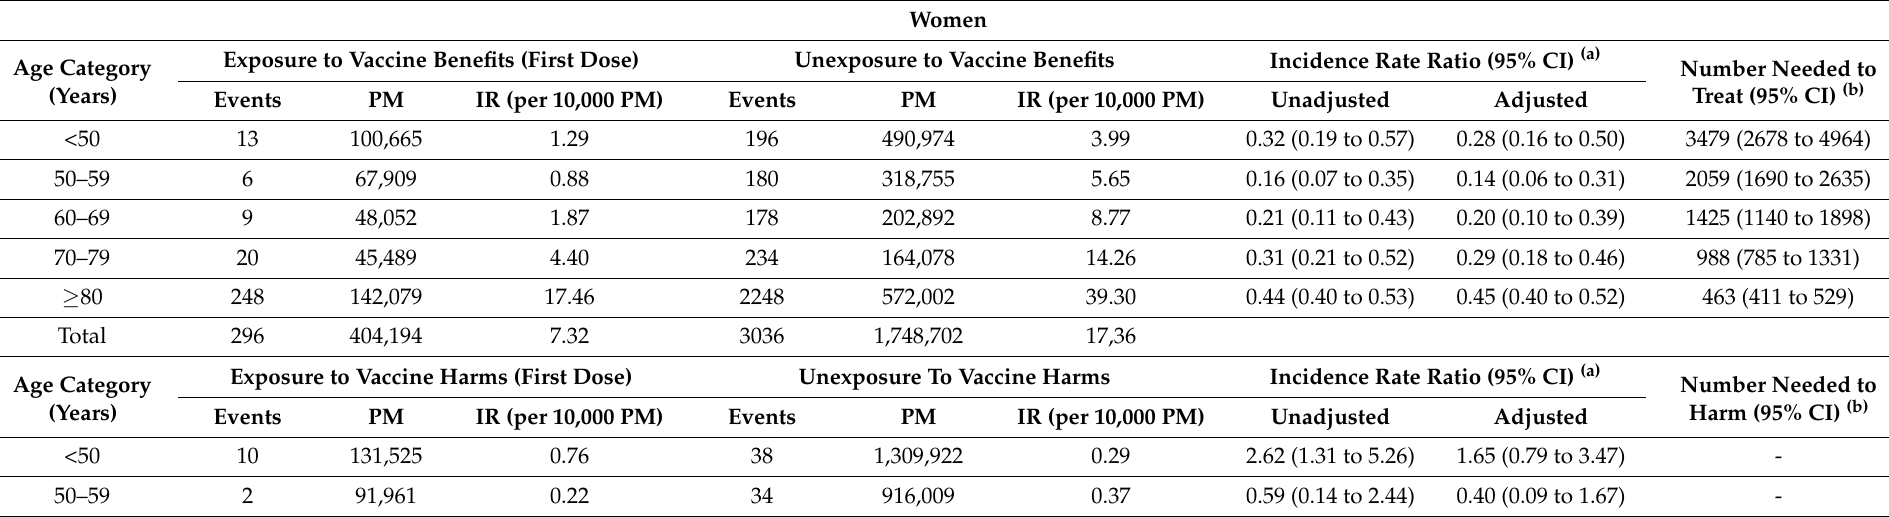
Table 3. Benefits—harms profile of mRNA-based vaccines (Pfizer or Moderna) in women and men of five age